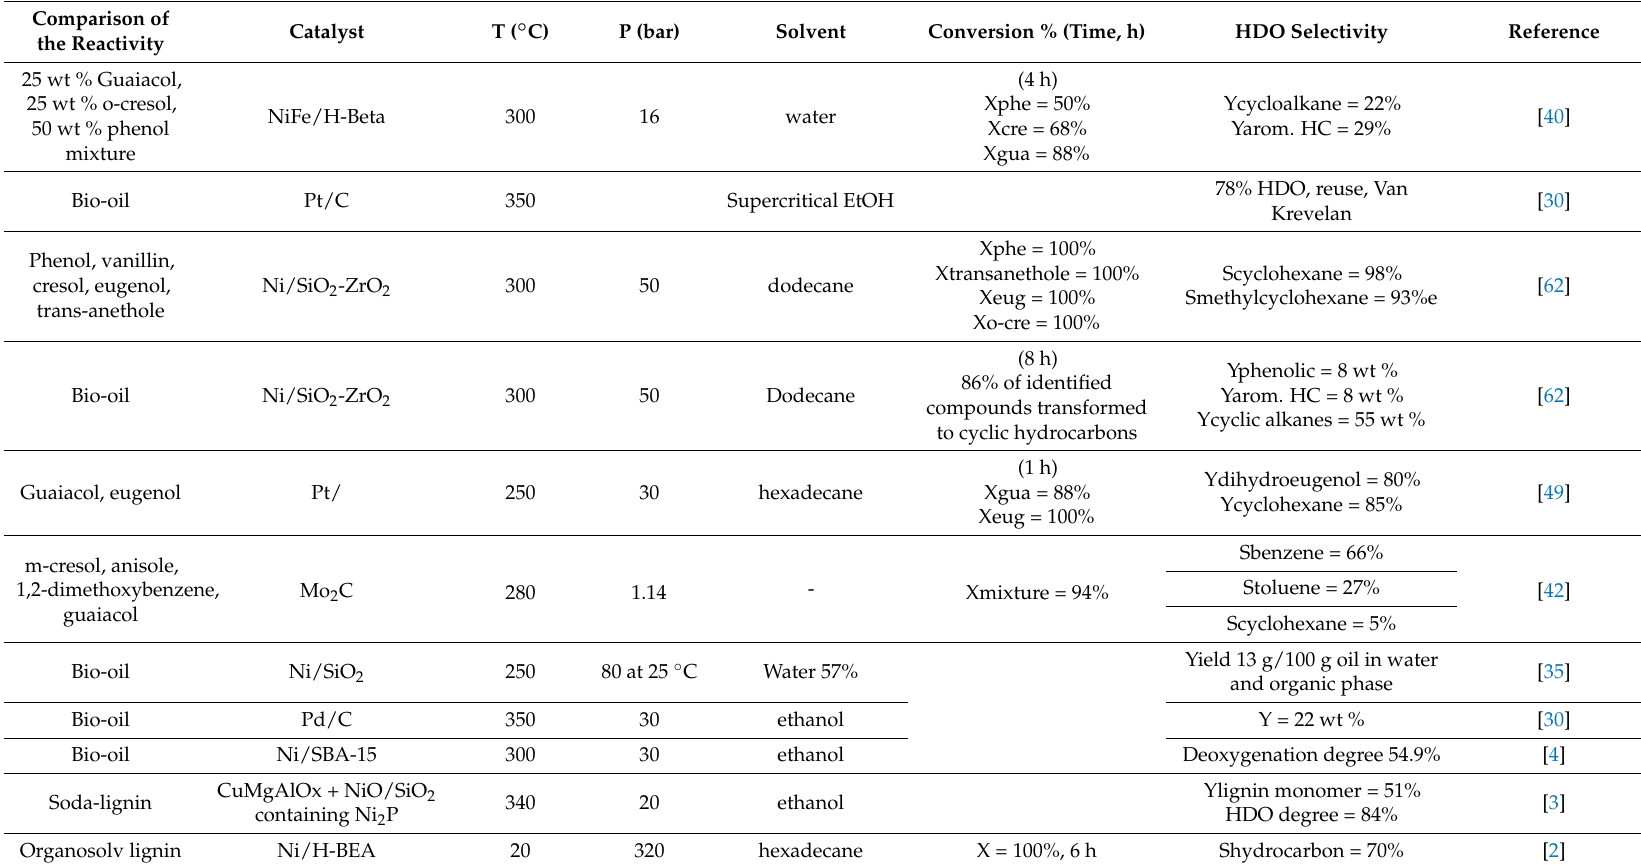
Table 4. Comparison of the HDO using mixtures or bio-oil. Notation: X is conversion, Y yield and S